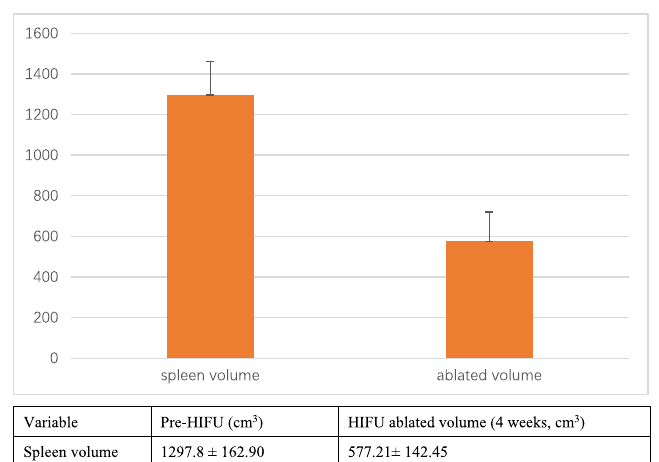
Figure 3. The pre-operative spleen volume and the HIFU ablated volume.